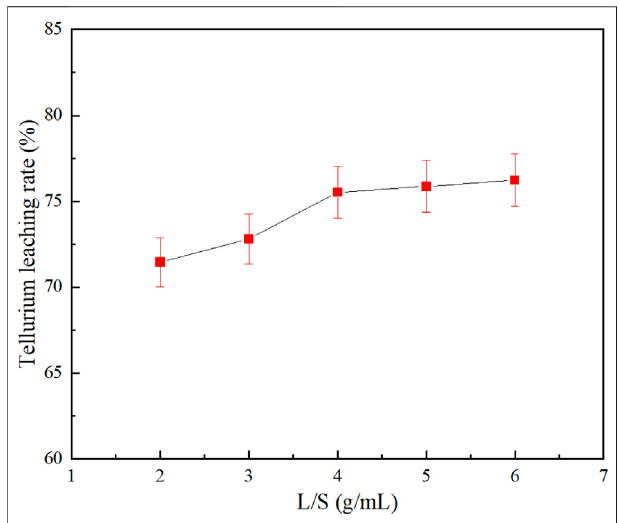
FIGURE 5 | Effect of liquid-solid ratio on tellurium leaching